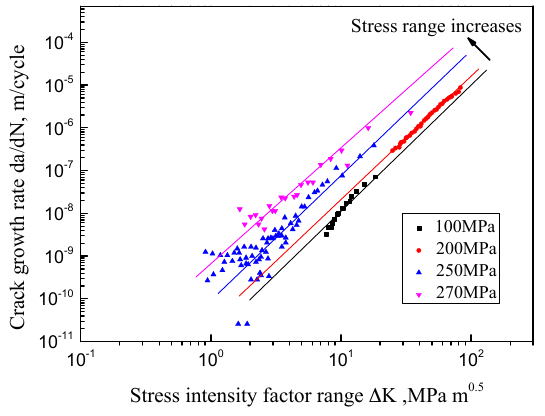
Figure 3. Crack growth rate vs. stress intensity factor (SIF) of 316 stainless steel.